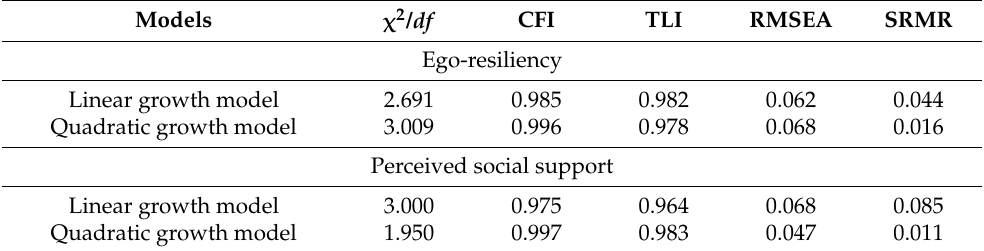
Table 2. Model Comparisons for Ego-Resiliency and Perceived Social Support.